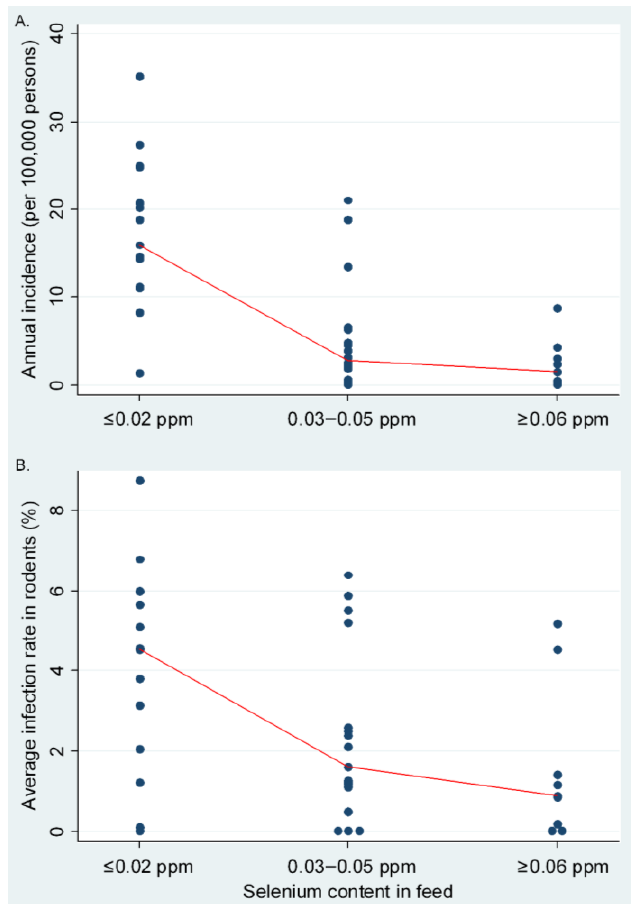
Figure 2. Correlation between both hemorrhagic fever with renal syndrome (HFRS) incidences in humans ( A ) and hantavirus infections in rodents ( B ) and selenium content. The rodent data were from 40 surveillance sites in Mainland China during the years 2005–2008. The points reflect ( A ) average incidences of HFRS in human for the counties each surveillance site and ( B ) annual average hantavirus infections in rodents for each surveillance site, and the lines represent the median bands. Selenium content of crops and feed ≤0.02 ppm represents severe selenium-deficient areas; 0.03–0.05 ppm represents moderate selenium-deficient areas; ≥0.06 ppm represents non-deficient